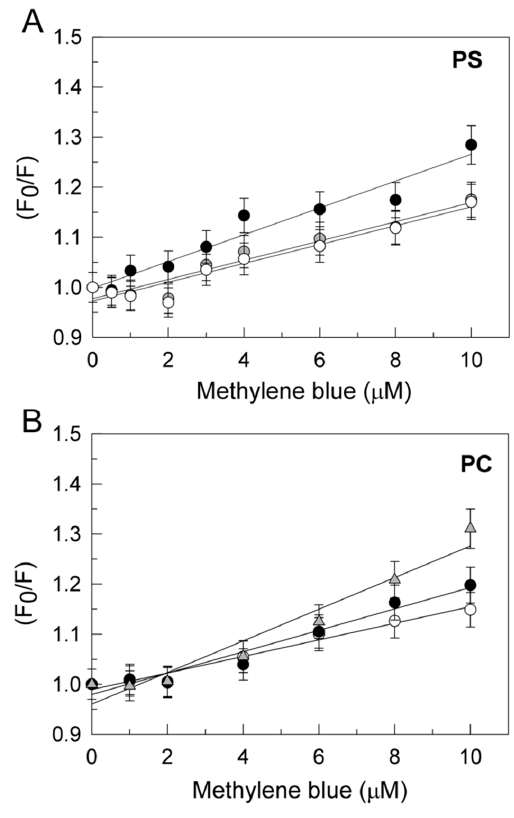
Figure 6. Tau modulates MB:PMCA interaction in purified pig brain PMCA. Stern–Volmer plots of the quenching by MB of the intrinsic fluorescence of 10 µg of purified PMCA from pig brain reconstituted in PS ( A ) or PC ( B ). Panel A: Results of titration with MB of PMCA reconstituted in PS